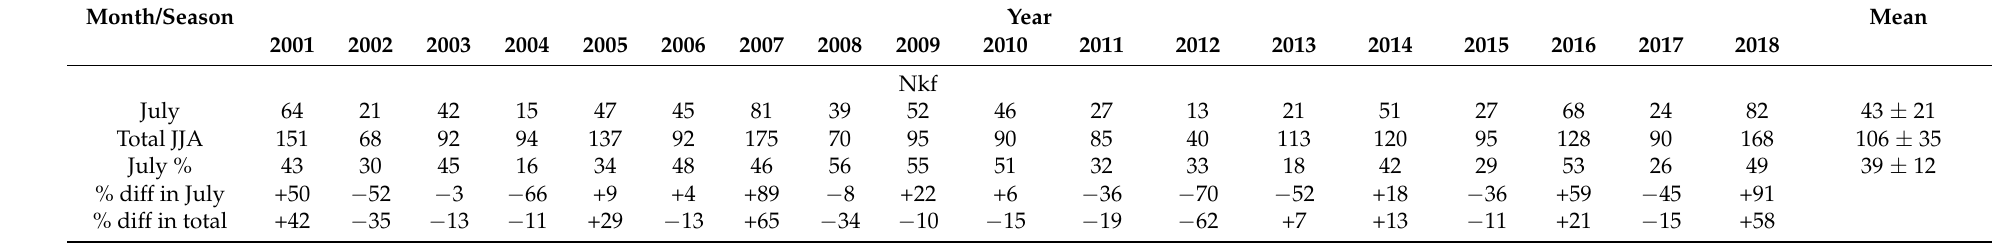
Table 3. Annual rainfall (mm) in July and total annual rainfall in JJA from 2001 to 2018 over Nakfa (Nkf) with the mean calculated. The percentage amount of rainfall in July, the percentage difference in July, and total rainfall from the mean (2001–2018) for each year are also given. − indicates % deficit and + denotes % excess of the mean rainfall in July and for the